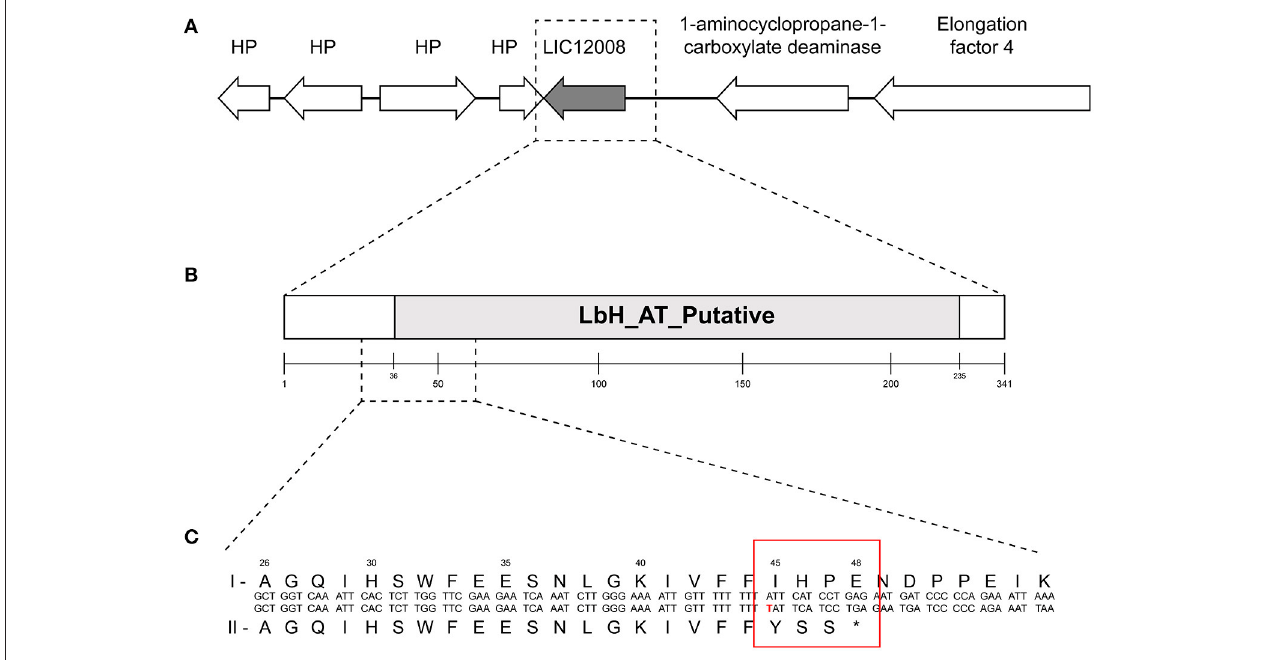
FIGURE 3 | Genomic organization and domain architecture of gene lic12008 . (A) Organization of lic12008 loci in L. interrogans serovars. (B) Domain architecture of LIC12008 protein. (C) Details of amino acid fragment (1-55aa) showing the sequence differences in L. interrogans Copenhageni (I) and L. interrogans Icterohaemorrhagiae (II)